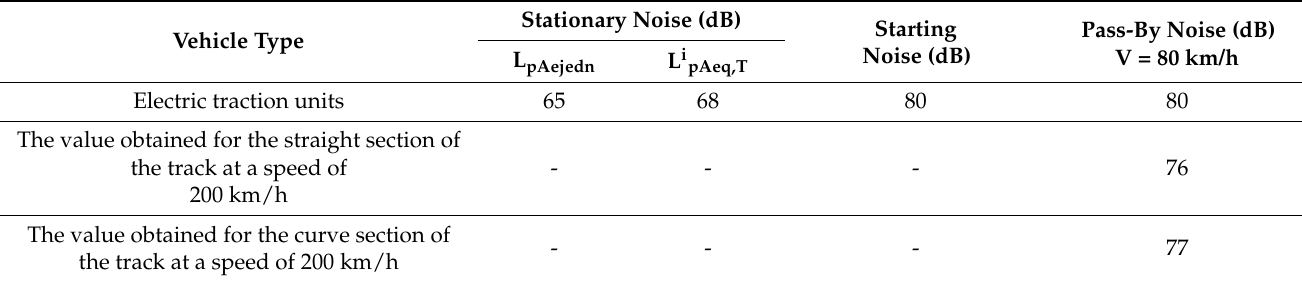
Table 2. Acceptable values of sound levels for the stationary noise, starting noise, and pass-by noise of electric traction units. Vehicle Type